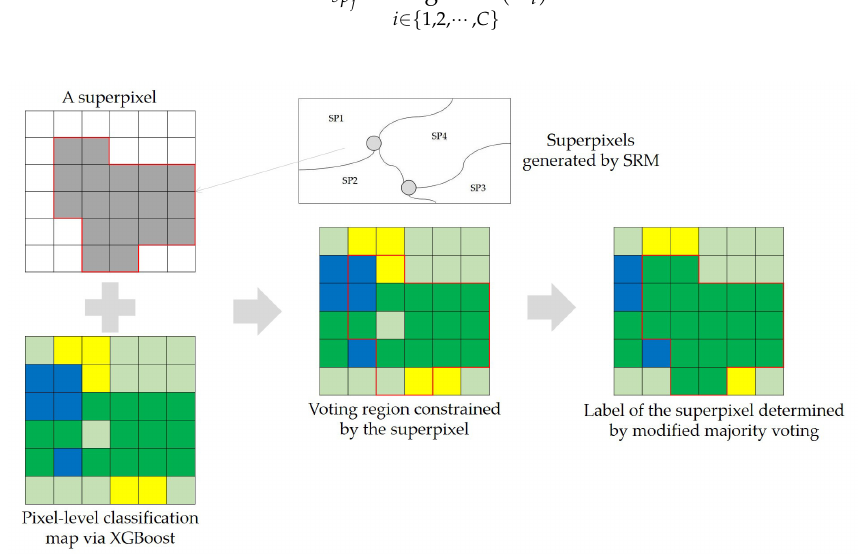
Figure 1. Incorporation of spatial information in the post-posting step via superpixels and modified majority voting. Class types are represented by corresponding colors.